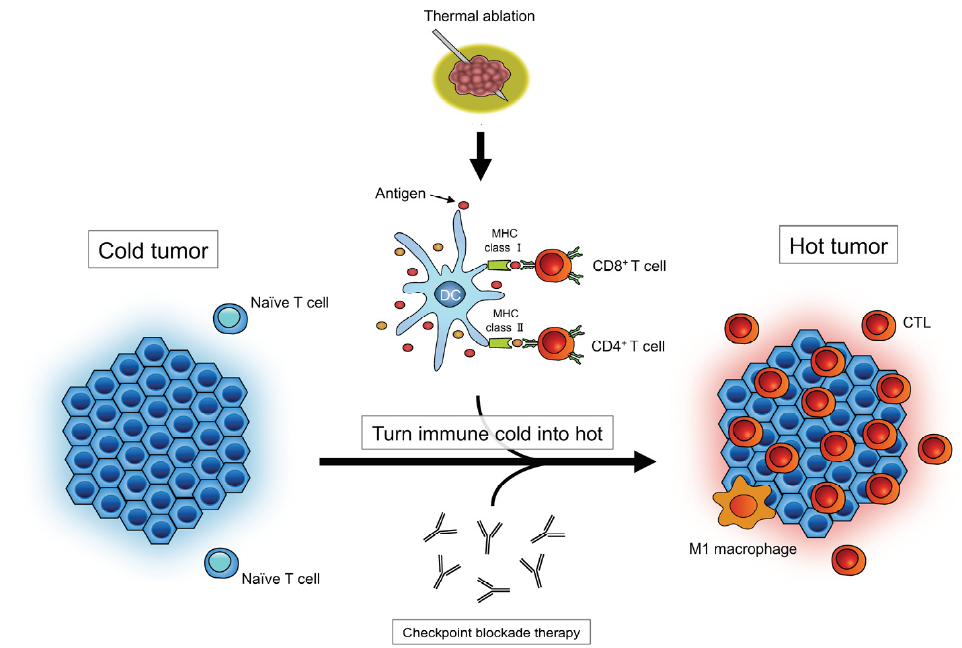
Figure 1. Activation of antitumor immune responses with thermal ablation. Note, CTL: cytotoxic T lymphocyte; DC: dendritic cell; MHC: major histocompatibility complex.